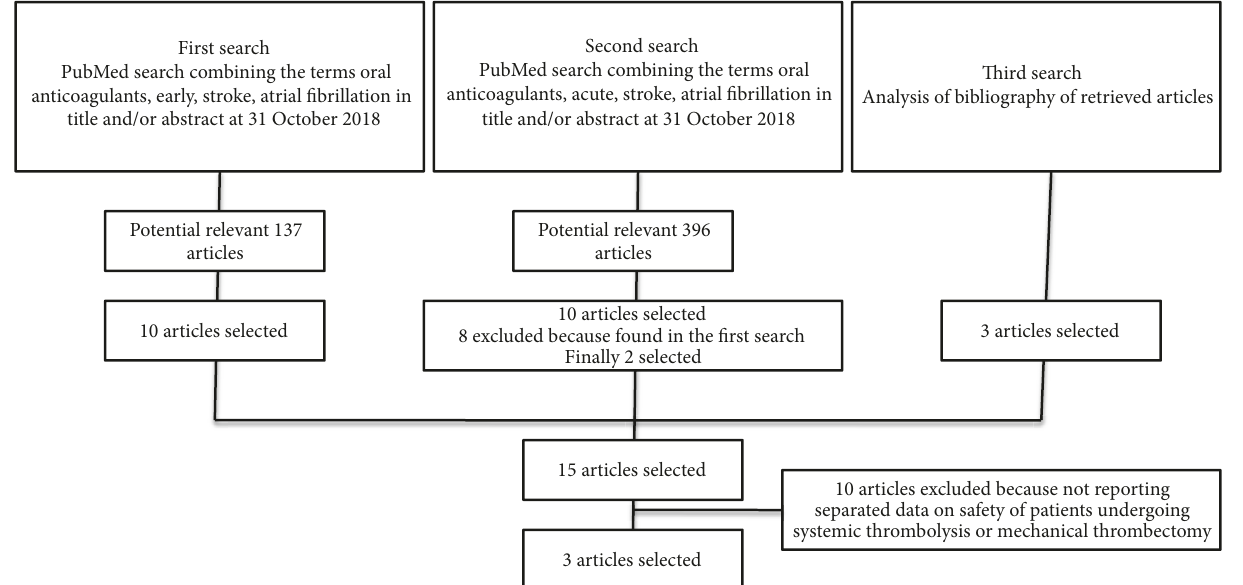
Figure 1: Flow diagram of selected